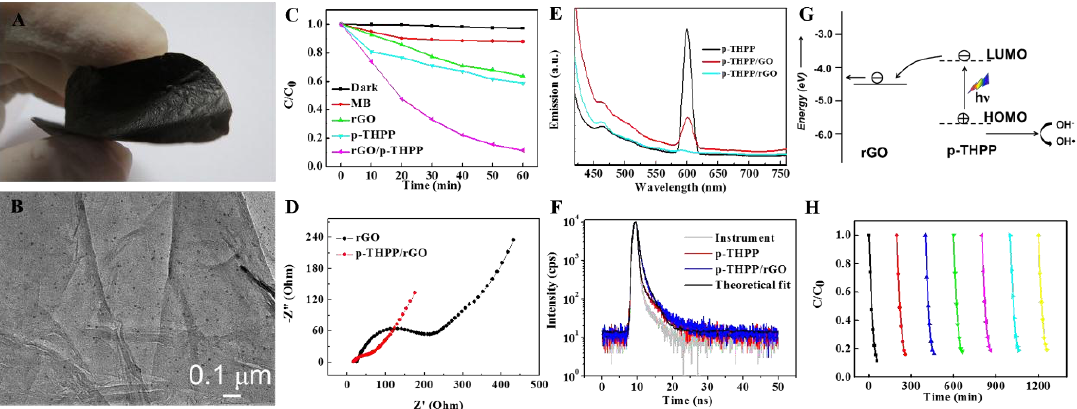
Figure 8. ( A ) The optical and ( B ) TEM images of free-standing meso-tetra (p-hydroxyphenyl) porphyrin (p-THPP)/rGO films; ( C ) photocatalytic degradation of MB with different samples under visible-light irradiation ( λ > 400 nm); ( D ) Nyquist plots collected by EIS of free-standing rGO and p-THPP/rGO films; ( E ) the fluorescence spectra of the synthesized films; ( F ) the fluorescence decay profiles of p-THPP and p-THPP/rGO nanohybrid in H 2 O ( λ exc = 405 nm); ( G ) proposed mechanism for the photocatalysis of the p-THPP/rGO film; ( H ) recycling experiment using the p-THPP/rGO for MB degradation under visible-light irradiation ( λ > 400 nm). Reproduced with permission from [92]. Copyright 2014, Royal Society of Chemistry.